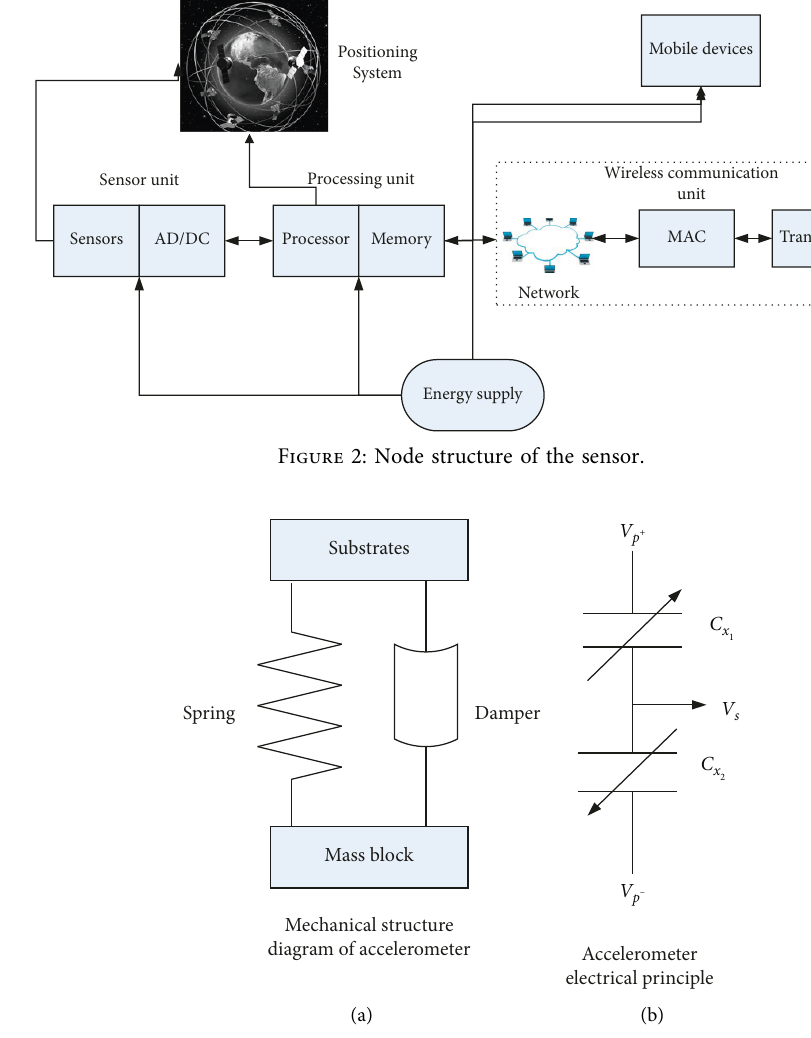
Figure 3: Schematic diagram of the working principle of accelerometer. (a) Mechanical structure diagram of accelerometer. (b) Ac- celerometer electrical